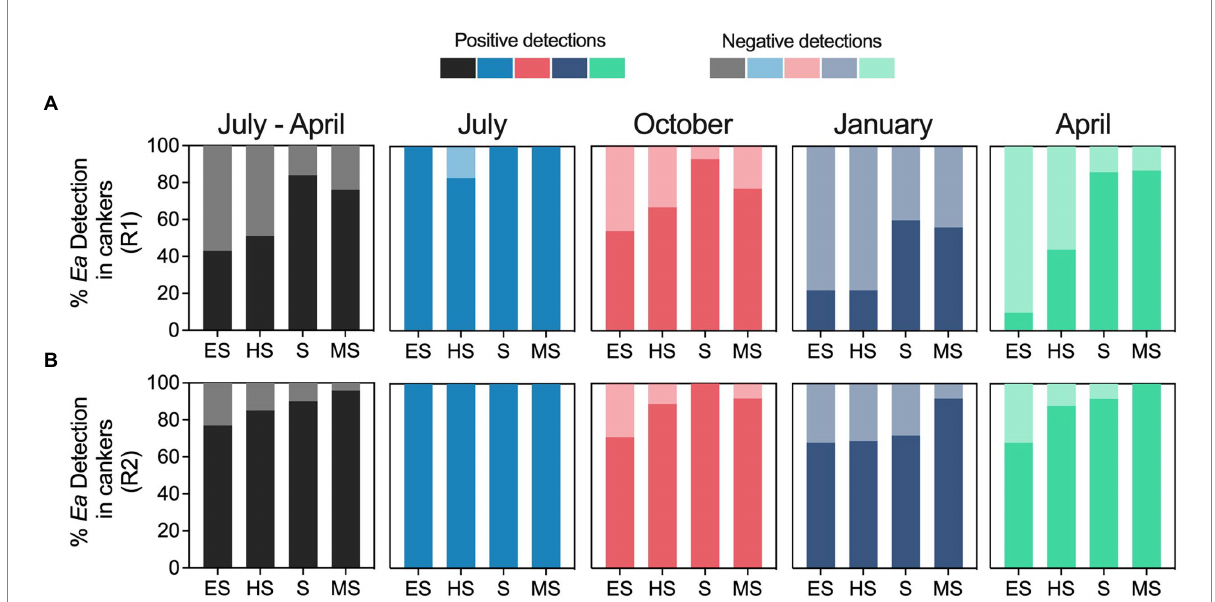
FIGURE 7 Relationship between the host’s susceptibility to fire blight and the E. amylovora detection rates in cankers over time. Charts show the percentages of positive and negative E. amylovora detection rates in cankers sampled from hosts classified as extremely susceptible (ES), highly susceptible (HS), susceptible (S) and moderately susceptible (MS) based on a fire blight susceptibility index (FBSI). Charts A and B show separated results of two independent experiments (R1 and R2, respectively). The black-colored charts on the left summarize E. amylovora detections rates in cankers pooling data from all the sampling points from July to April. The following four charts in each row, colored in pale blue, red, dark blue and green show separately the percentages of E. amylovora detections in cankers sampled in July, October, January, and April,